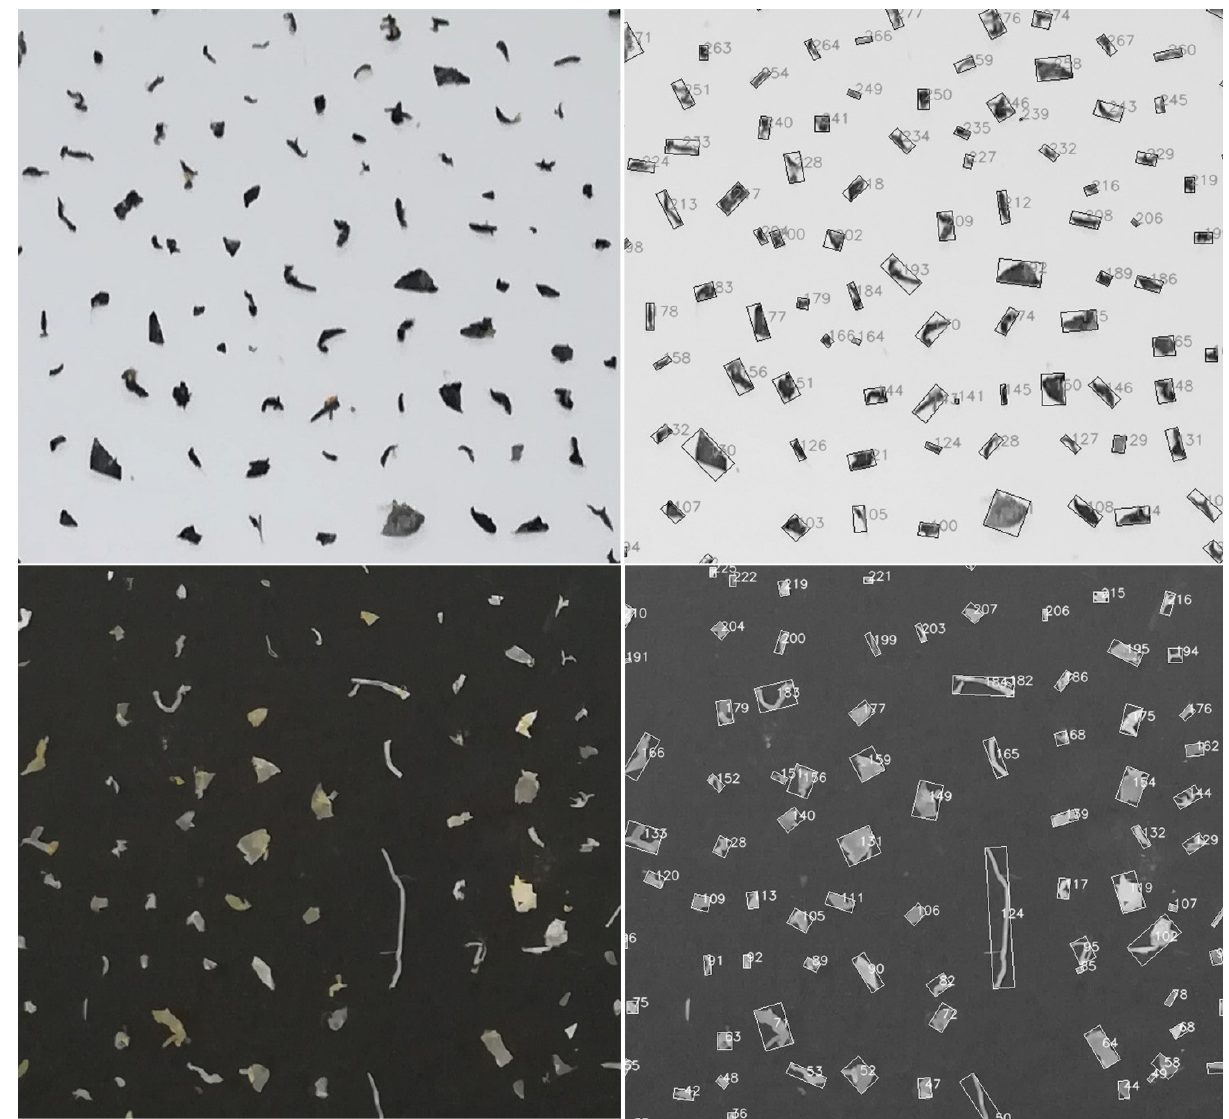
Figure 3. ( left ) MPs and background filters; ( right ) example of Bounding boxes generated with different background fil- ters.